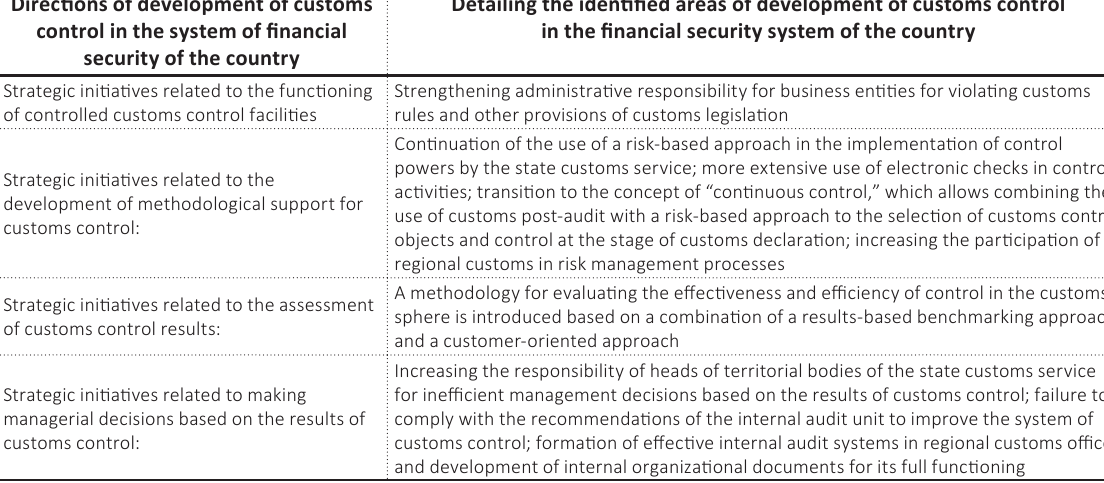
Table 4 (cont.). Directions of development of customs control in the system of financial